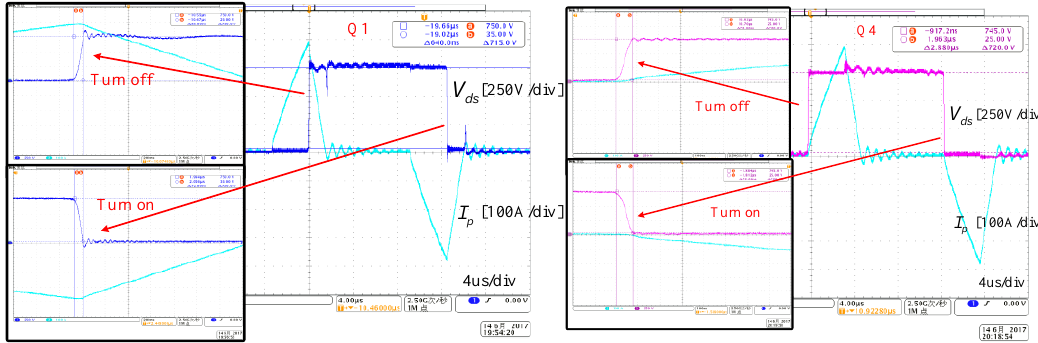
Figure 16. The full-bridge inverter waveform.